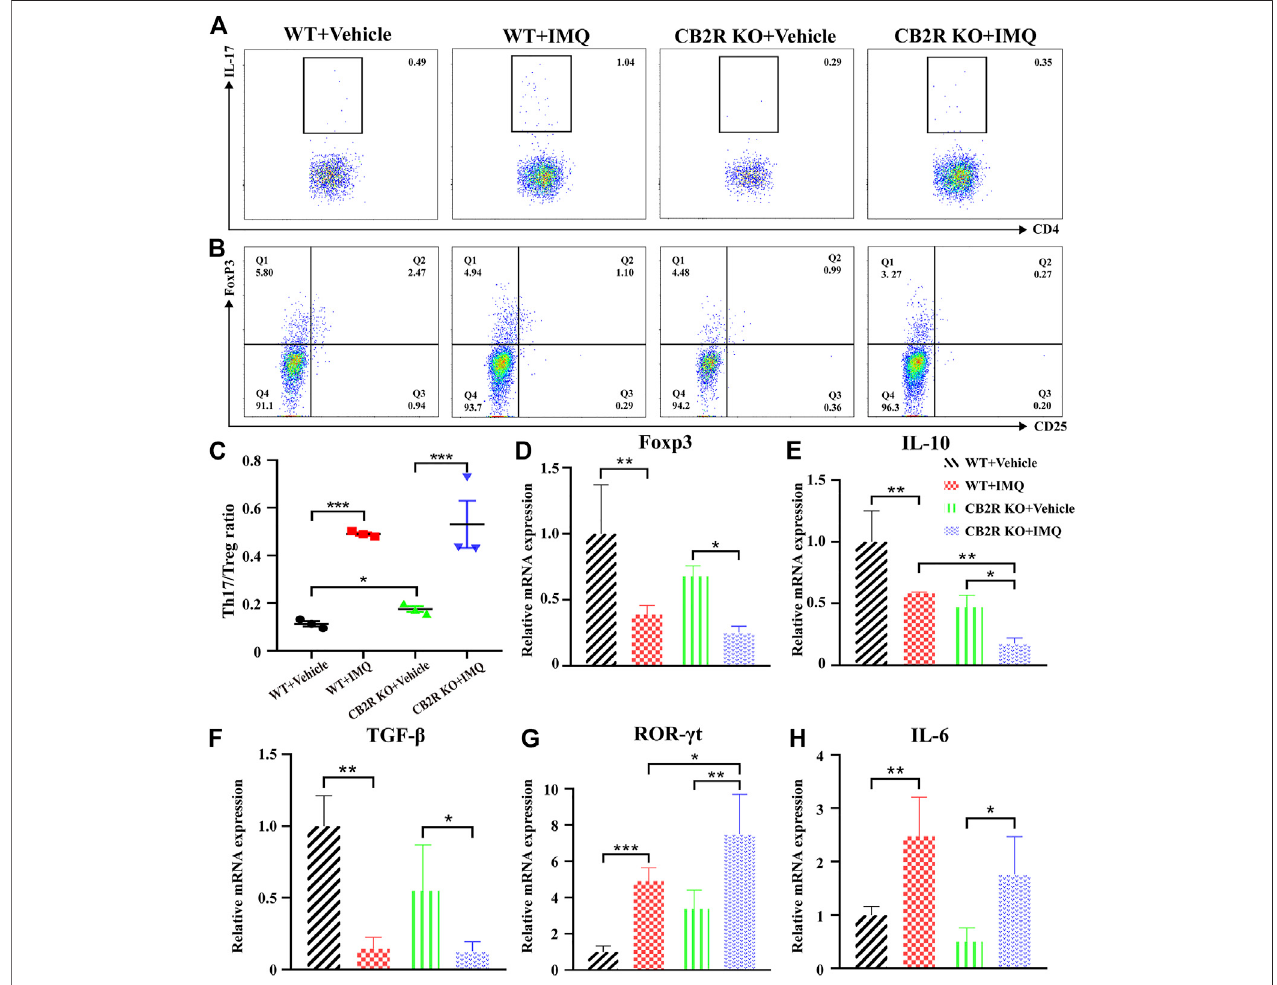
FIGURE 3 | Effects of CB2R de fi ciency on differentiation proportion of Th17/Treg in IMQ-induced PsD. (A) Flow cytometric analysis of the proportion of Th17 cells (CD4 + , IL-17A + cells) in single cell suspensions of spleen of IMQ- and vehicle- treated skin in WT and CB2R KO mice. (B) Flow cytometric analysis of the proportion of Treg cells (CD4 + , CD25 + , and Foxp3 + cells) in single cell suspensions of spleen of IMQ- and vehicle- treated skin in WT and CB2R KO mice. (C) The ratio of Th17/Treg cells. (D-H) ThemRNAexpression levelsofFoxp3 (D) ,IL-10 (E) ,TGF- β (F) ,ROR- γ t (G) ,IL-6 (H) .Errorbars represent mean±SD. * p < 0.05,** p < 0.01, and*** p < 0.001 when